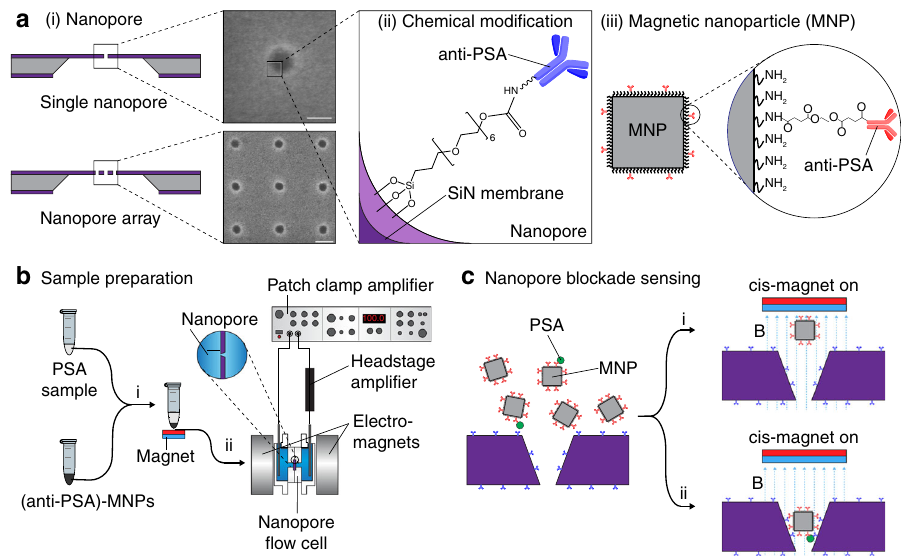
Fig. 1 Nanopore blockade sensor. a (i) Schematics and scanning electron micrographs of (top) a solid-state nanopore, inset: a 48 nm nanopore, scale bar: 100 nm; (bottom) a nanopore array in SiN membrane, inset: a 3 × 3 array of nanopores with 0.5 μ m spacing between each pores, scale bar: 200 nm. (ii) Illustration of a chemically modi fi ed SiN nanopore with silane-EG 6 -(anti-PSA) self-assembled monolayer (SAM); EG equates to ethylene glycol. (iii) Illustration of an (anti-PSA)-conjugated MNP used in this work. Inset: chemical structure of the (anti-PSA)-EG 6 immobilised onto the amine-rich PEI coating of the MNP. b Flow chart illustrates the sample preparation steps for detection of PSA in a sample. (i) Sample containing PSA was mixed with (anti- PSA)-MNPs. After exposing the MNPs to the sample, the MNPs were then magnetically separated and washed 3 times with PBS. (ii) The MNPs